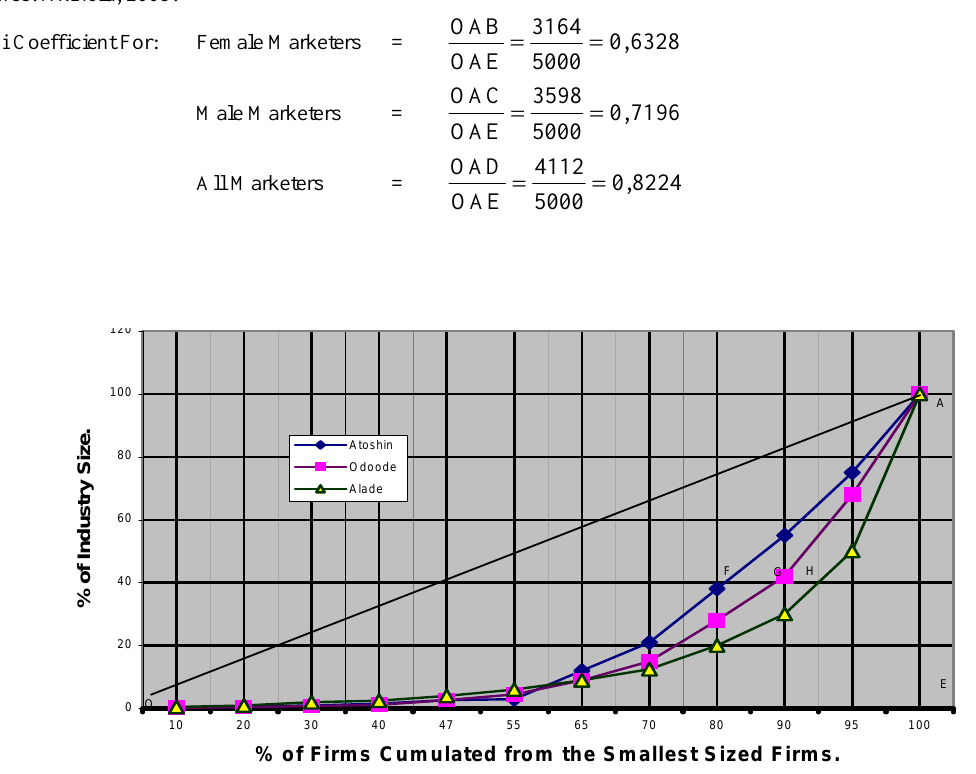
Figure 1: Lorenz curves for marketers in cocoa industry in Idanre, Ondo State, Nigeria. 2000/2001 Seaso n Source: Akinola, 2003.